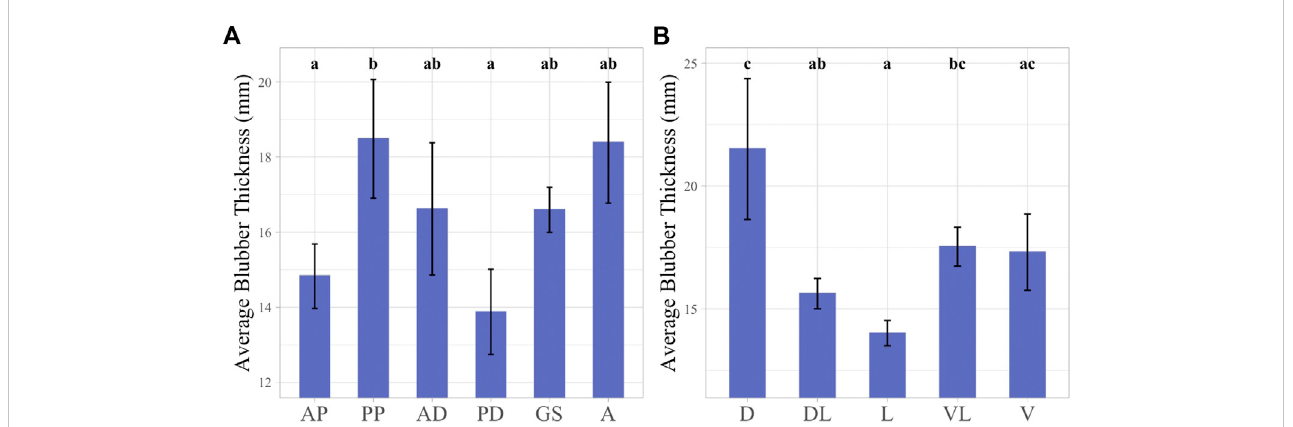
FIGURE 3 LinearmixedeffectmodelsillustratingaverageBTacrossgirthaxes (A) andsamplingplanes (B) .Girthaxeslabeledwith1-2letteridenti fi er, “ AP ” =Anterior Pectoral, “ PP ” = Posterior Pectoral, “ AD ” = Anterior Dorsal, “ PD ” = Posterior Dorsal, “ GS ” = Genital slit, “ A ” = Anus. Sampling planes labeled with 1-2 letter identi fi er, “ D ” = Dorsal, “ DL ” = Dorsolateral, “ L ” = Lateral, “ VL ” = Ventrolateral, “ V ” = Ventral. Signi fi cant differences between factors illustrated by lowercase letters above each bar graph. Groups with any shared letters are not signi fi cantly different to each other. Error bars represent standard